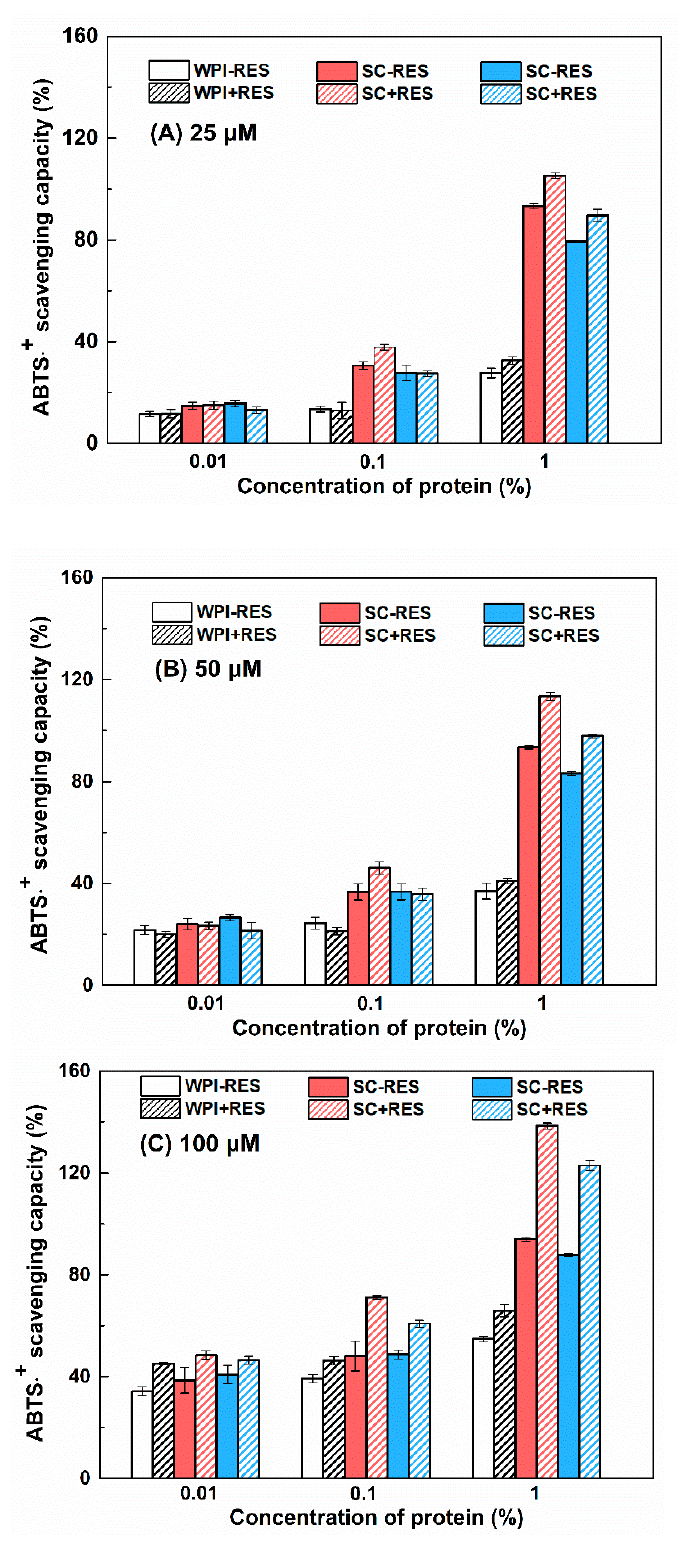
Figure 6. ABTS · + scavenging capacity of resveratrol, WPI (black), SC (red), SPI (blue) and WPI- resveratrol, SC-resveratrol and SPI-resveratrol complex nanoparticles. The concentrations of proteins were 0.01%, 0.1% and 1%, while the concentrations of resveratrol were 25 ( A ), 50 ( B ) and 100 ( C ) µ M.